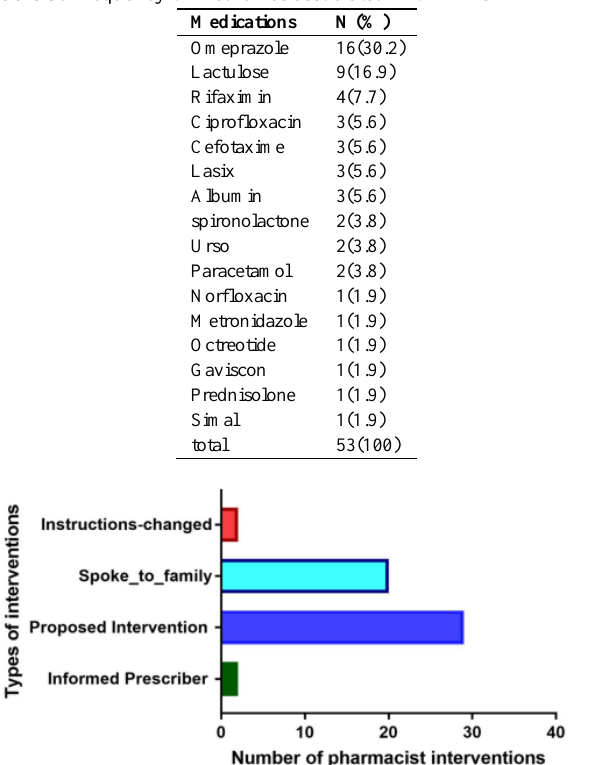
Table 3: Frequency of medicines associated with DRPs